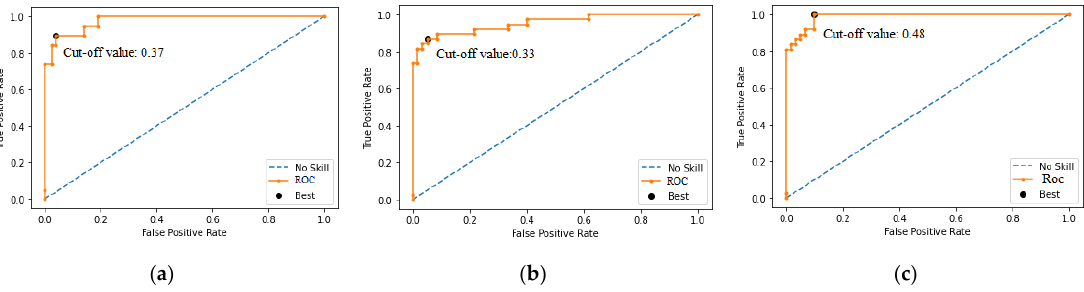
Figure A2. Performance of ROC curve for RGB-CNN: ( a ) Infarction; ( b ) ischemia; and ( c ) normal.